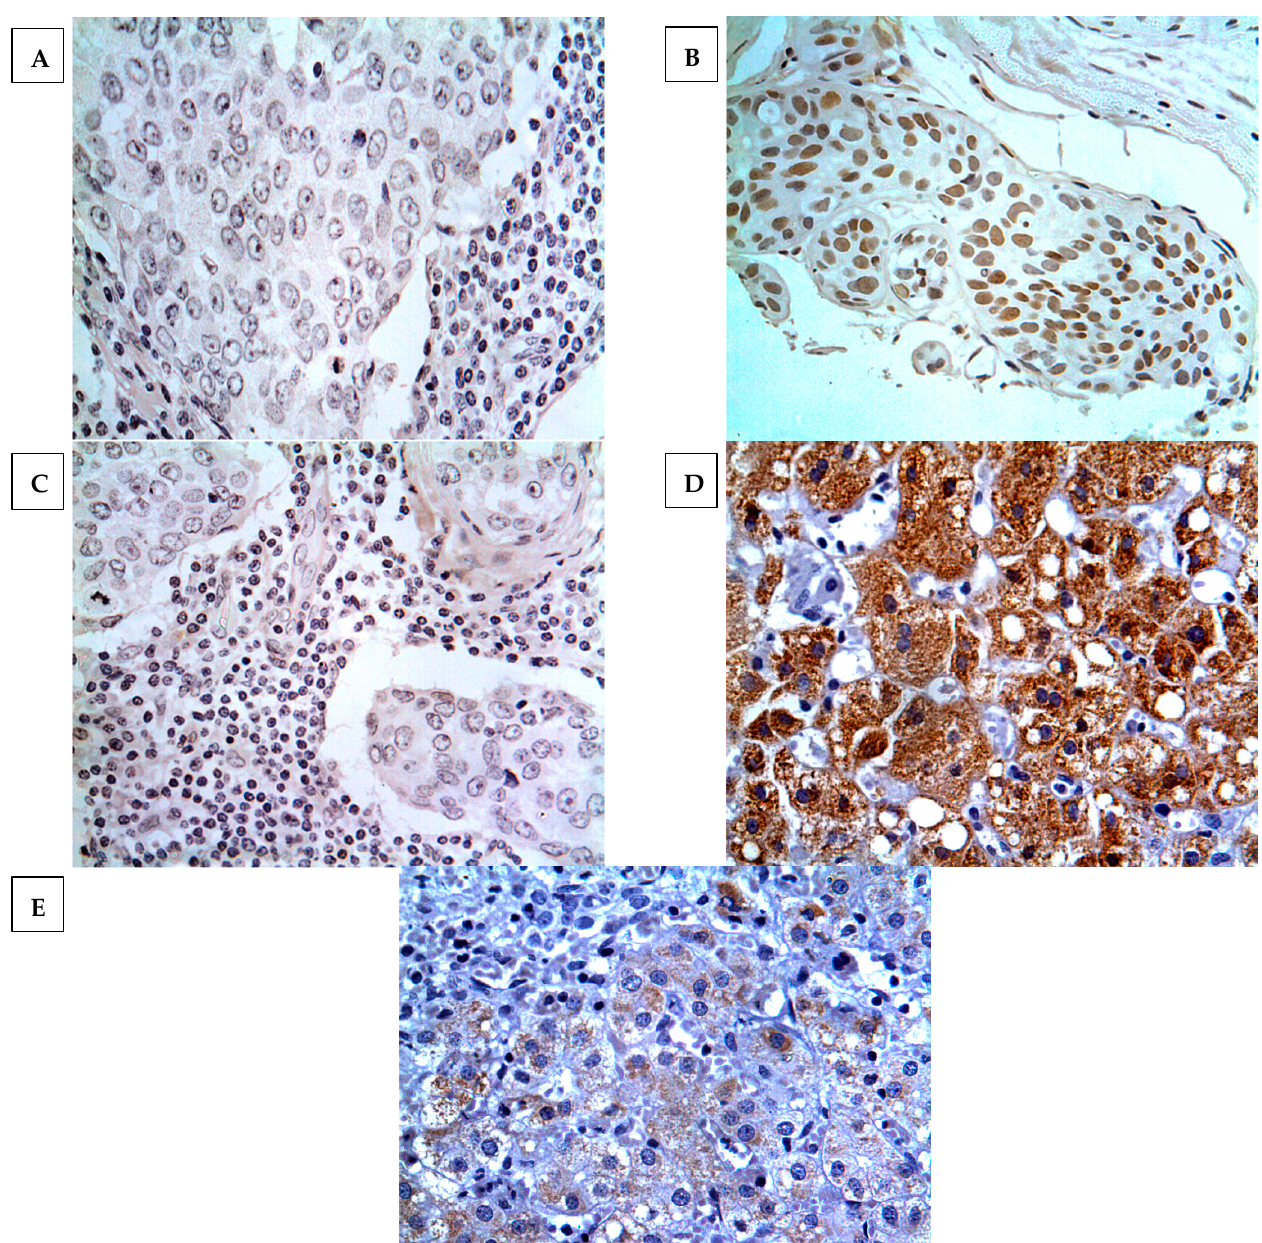
Figure 1. GPC3 expression in different histological subtypes of breast cancer. Classification was per- formed according to histopathological subtype. ( A ): normal breast tissue, ( B ): invasive ductal carci- noma, ( C ): invasive lobular carcinoma, ( D ): intraductal carcinoma, ( E ): mucinous adenocarcinoma, ( F ): Paget’s disease. Magnification x400.